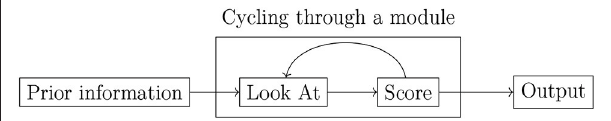
FIGURE 3 | A single module. The student can go back to look at content and then repeat the test, over and over. This is called a directed cyclical graph.